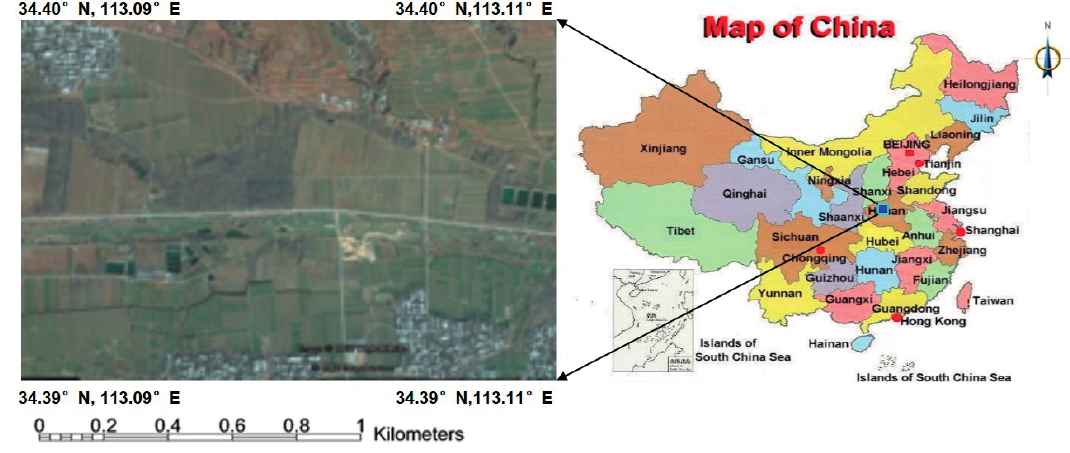
Figure 1. The optical image of the study area (copyright Google Earth).